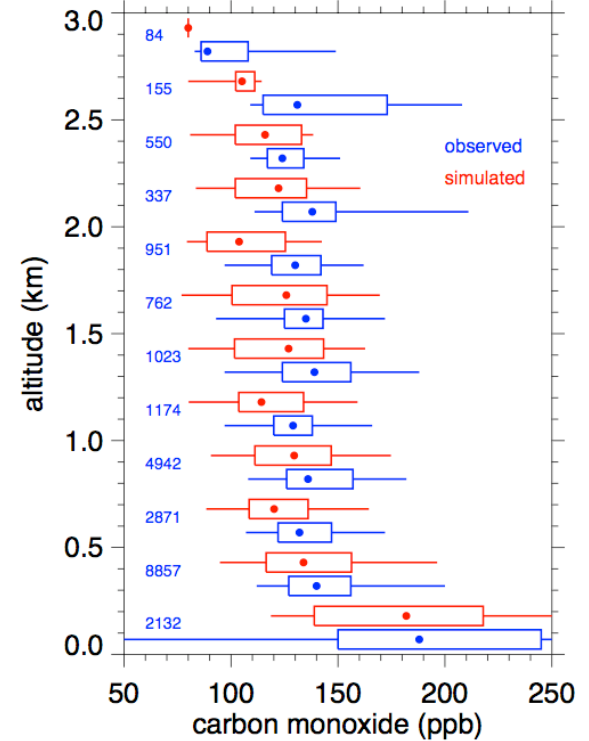
Figure 13. Observed (blue) and simulated (red) carbon monoxide binned over 250-m increments along all 1009 Fig. 13. Observed (blue) and simulated (red) carbon monoxide of the G-1 flight paths, expressed in terms of percentiles. Dots denotes 50 th percentile, boxes denotes 1010 binned over 250-m increments along all of the G-1 flight paths, ex- pressed in terms of percentiles. Dots denotes 50th percentile, boxes range between 25 th and 75 th percentiles, and lines denote 5 th and 95 th percentiles. 1011 denotes range between 25th and 75th percentiles, and lines denote 5th and 95th